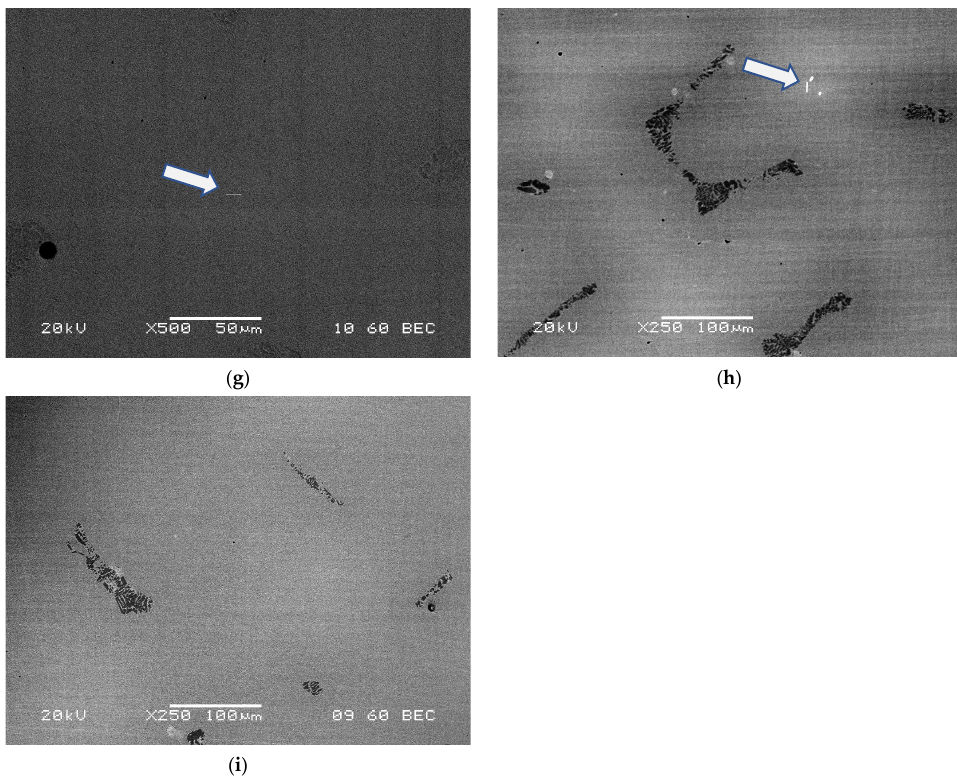
Figure 5. The microstructure of the dendritic cores of CMSX-10N samples of solution times: as-cast ( a ), 0 h ( b ), 1 h ( c ), 4 h ( d ), 8 h ( e ), 12 h ( f ), 16 h ( g ), 24 h ( h ), and 48 h ( i ). TCPs are indicated by arrows.